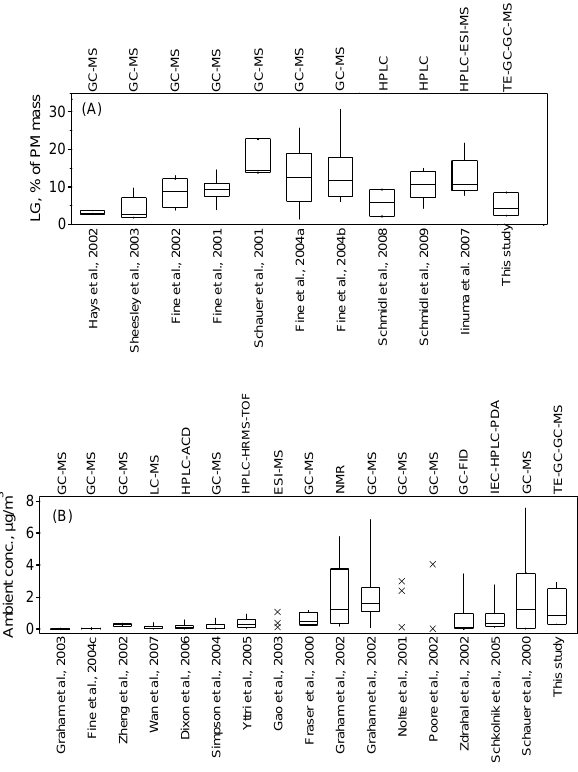
Fig. 4. Literature-reported LG concentrations compared to those of the present study. (a) LG concentrations measured during biomass burning source tests with variable biomass fuel types and analyti- cal techniques (% PM mass). The bottom, middle, and top of the box plots correspond to the 25, 50, and 75 percentile of each data set; the bottom and top of the whiskers indicate the 10 and 90 per- centiles, respectively. (b) Analytical method-based LG concentra- tions (µg/m 3 ) in ambient atmospheric aerosols collected globally. Studies with limited data sets precluding box plot creation are in- dicated by X symbols, which are the data points available for that particular